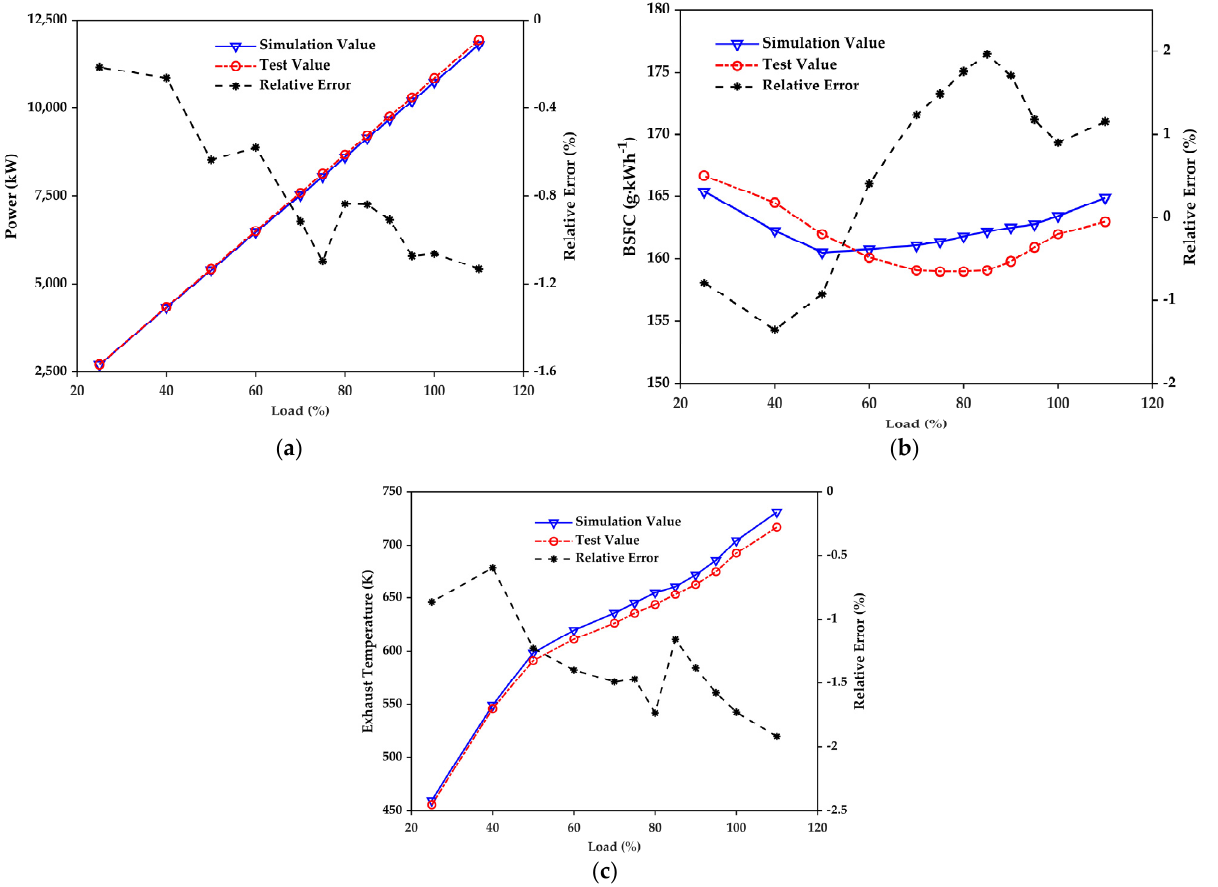
Figure 4. Comparison of simulation results to experimental data in steady ‐ state performance: ( a ) power variation trend with load, ( b ) BSFC variation trend with load and ( c ) exhaust temperature variation trend with load.